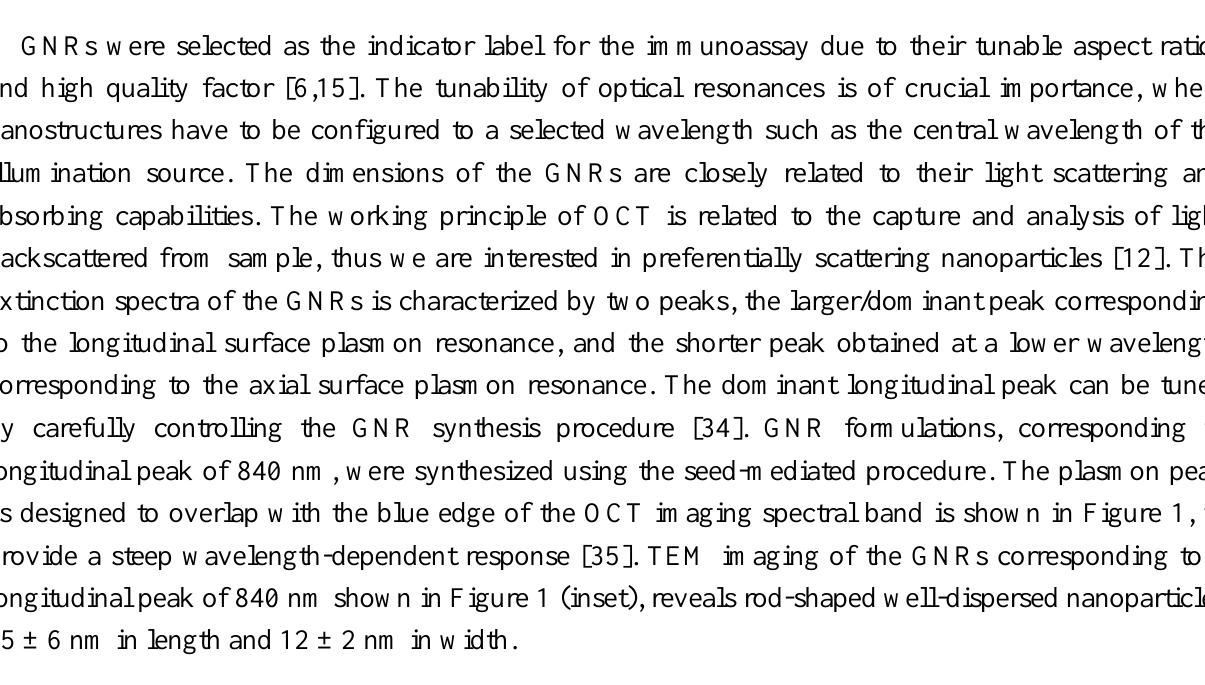
Figure 1. Extinction spectrum of gold nanorods (GNRs) (black line) and relative intensity of (optical coherence tomography) (OCT) imaging light (red line). Inset: transmission electron microscopy (TEM) image of bare GNRs corresponding to longitudinal peak of 840